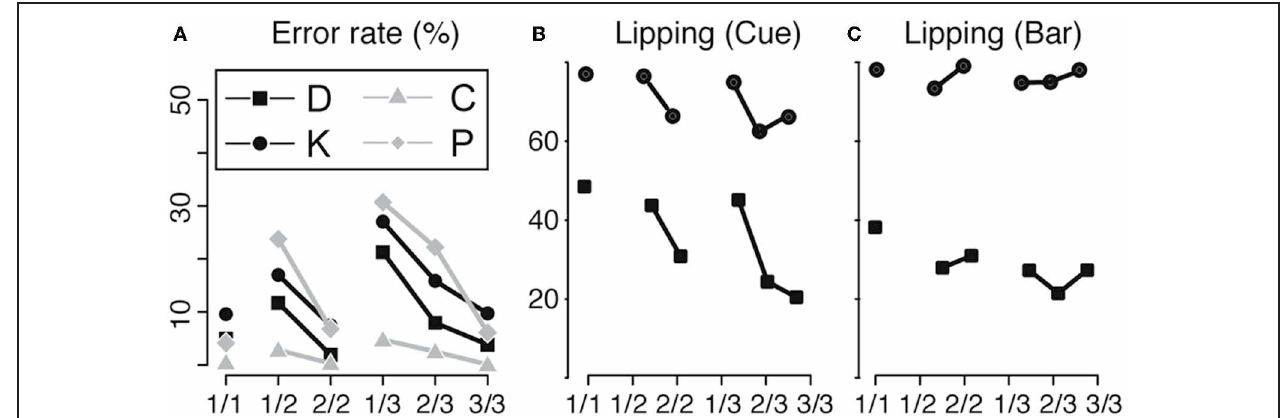
FIGURE 2 | Behavior. (A) Bar release. Error rate for the operant response (bar release) across the six schedule states, indicated by fractions, for the four animals (D, K, C, and P). The error rate is minimal in rewarded trials (1/1, 2/2, and 3/3), indicating that monkeys knew the task and were motivated enough to work when a reward was immediately available upon trial completion. In non-rewarded trials, the error rate increased with the distance to the reward, indicating a decrease in motivation to perform the operant response when more effort/time was required to obtain the reward. (B,C) Lipping behavior. Percentage of trials with a lipping response at the cue (B) and the bar release (C) across the six schedule states (indicated by